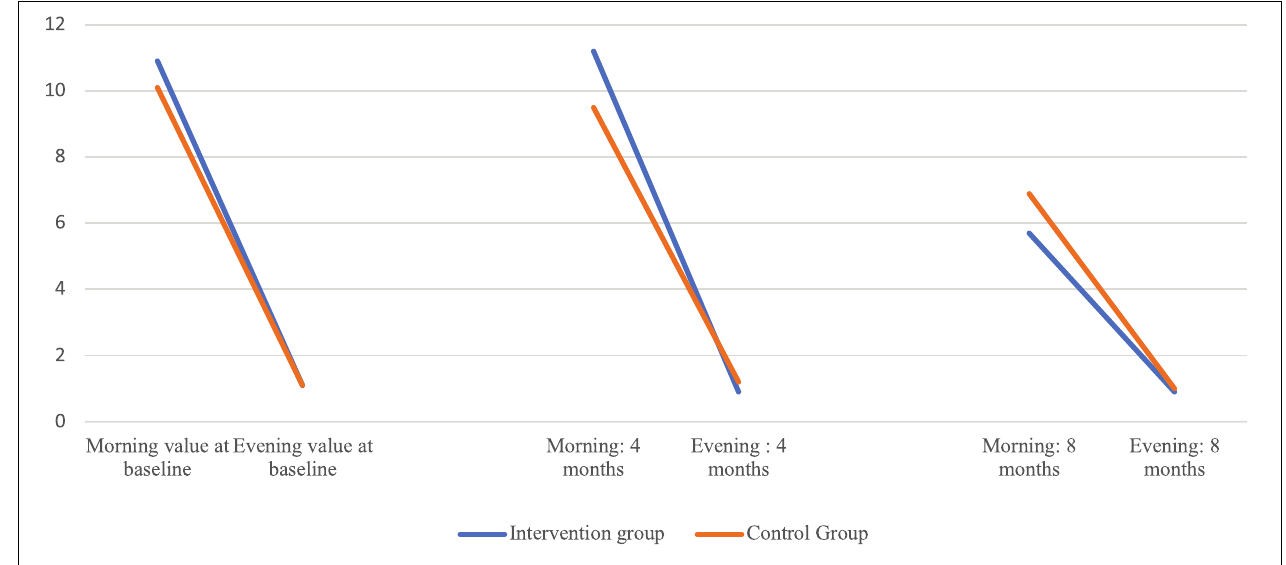
FIGURE 2 | Graphic illustration of morning and evening cortisol levels (nmol/L) at baseline, 4 and 8 months in the intervention and control groups.